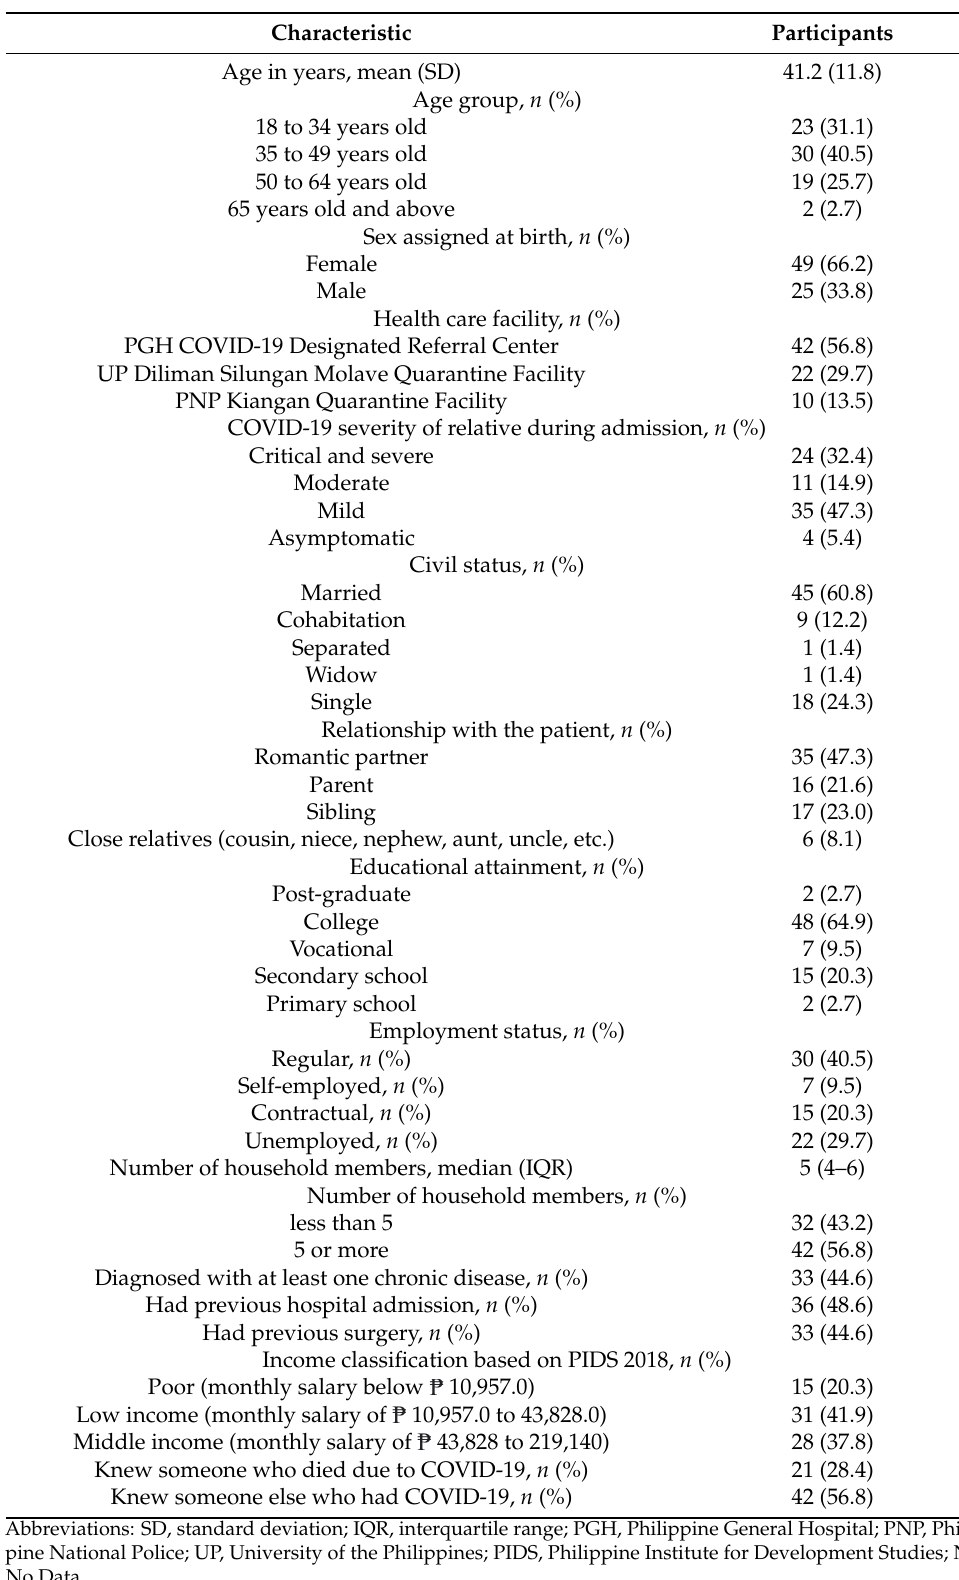
Table 1. Baseline sociodemographic characteristics of the family members of patients who completed the two interviews ( n =